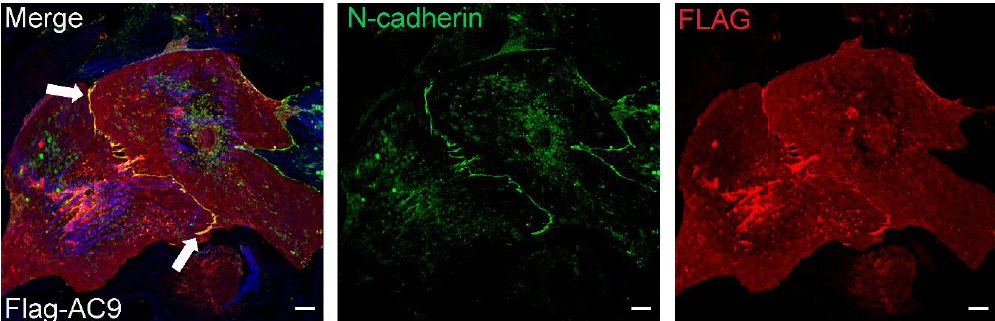
Figure 7. AC9 co-localizes with N-cadherin at the plasma membrane and points of cell – cell contacts in neonatal rat cardiomyocytes. Neonatal rat CMs were infected with Flag-AC9d for 60 h then stained with N-cadherin (green), FLAG (red), and phalloidin (blue). Arrows point to co-localization of AC9 with N-cadherin at the plasma membrane or points of cell – cell contact. Individual channels are shown to the right of composite images. Scale bar represents 10 µm, n > 10 cells per condition from ≥2 CM isolations.